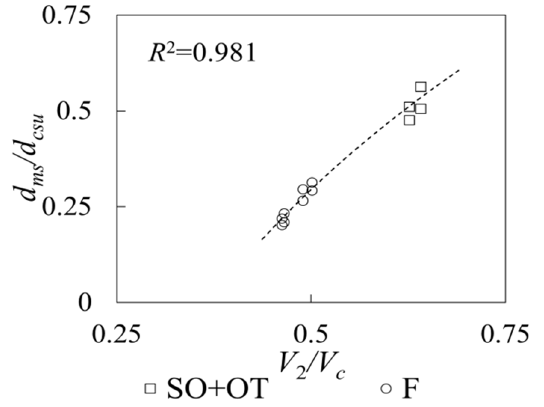
Figure 5. Comparison of CSU and M/S pier scour depth in terms of flow intensity.